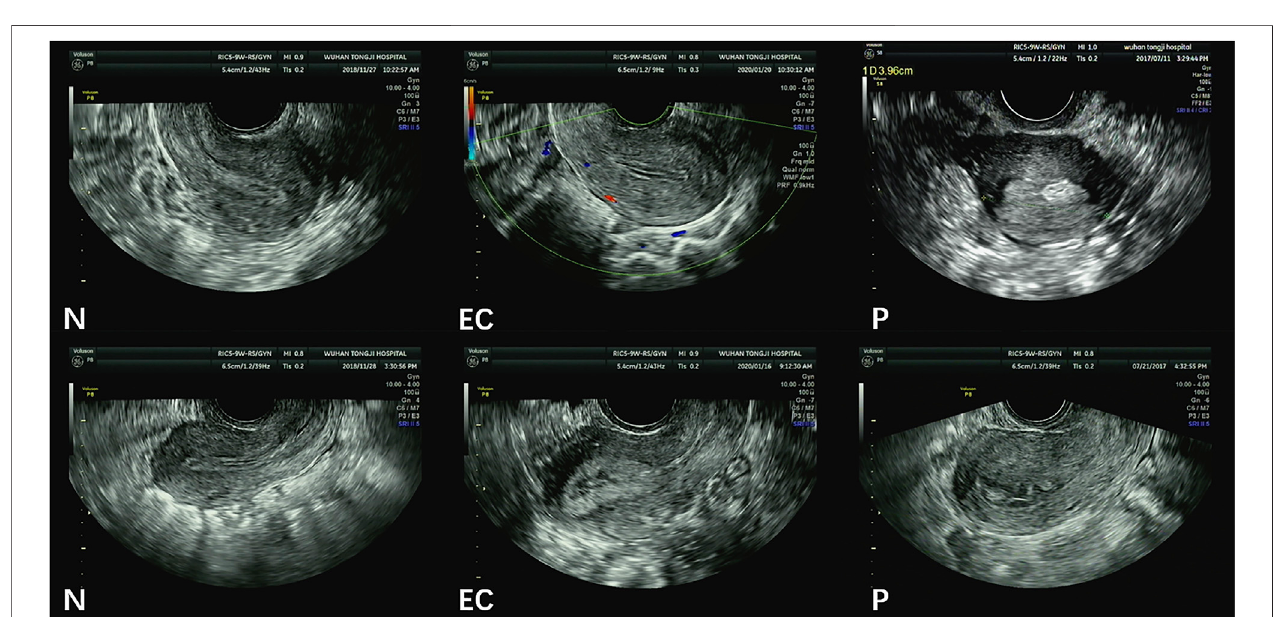
FIGURE 2 | Sample TVUS images. (N = normal endometrium, EC = endometrial cancer, P = endometrial